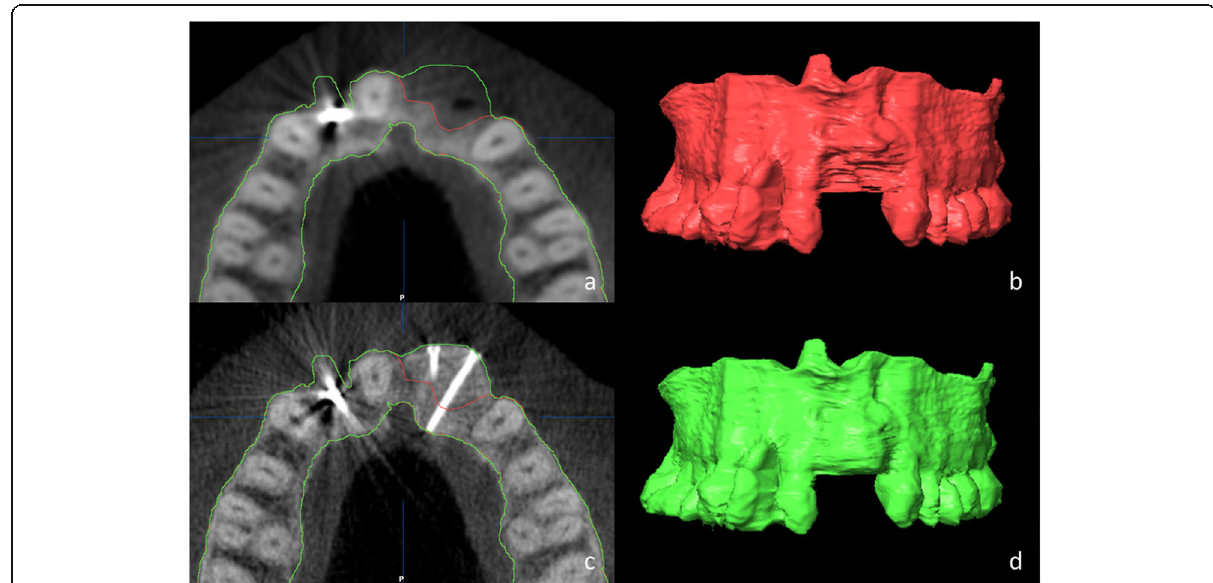
Fig. 3 a , c The axial view of the pre- and post-operative radiological situation with the corresponding borders marked in red (pre-operative situation) and green (post-operative situation). b , d The corresponding segmented models